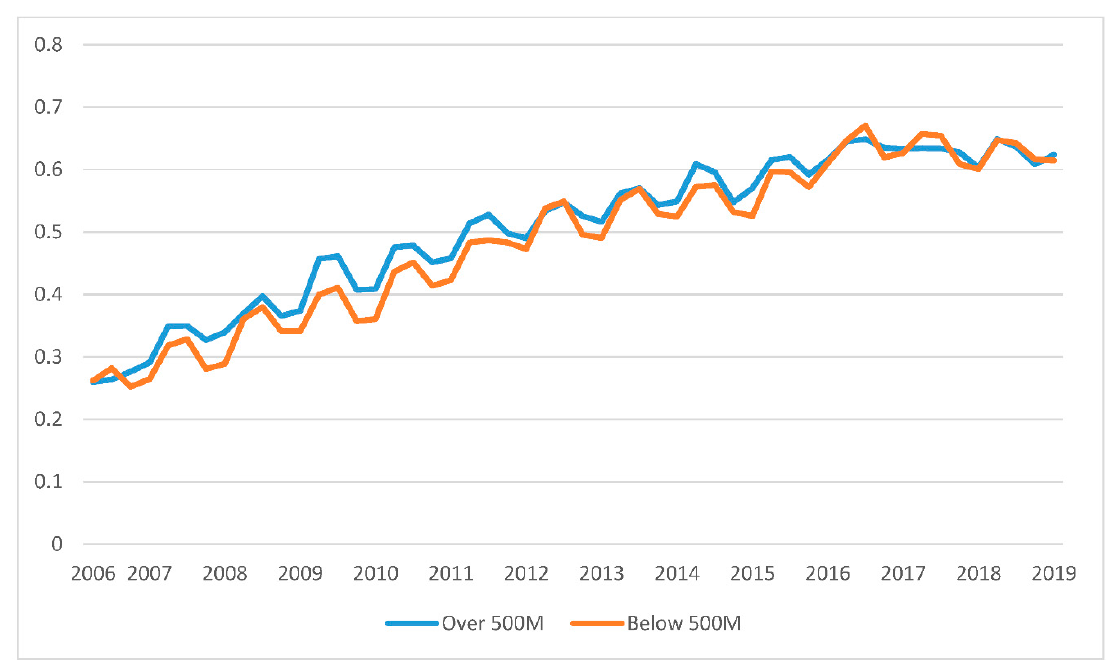
Figure A6. Average recycling rate for local authorities with more/less than 10,000 nights spent in by domestic travellers per year. Source: WasteDataFlow and the Tourism Profile.